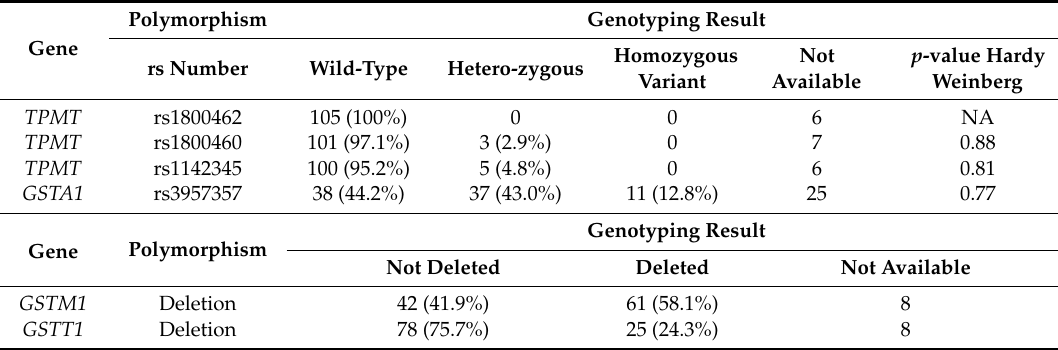
Table 4. Genotype distribution in the 111 patients enrolled in the study.